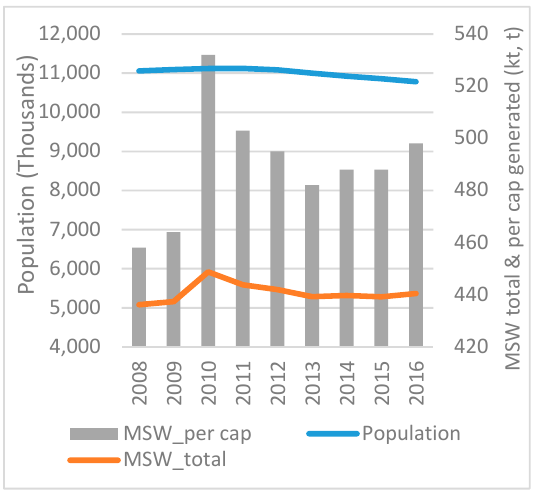
Figure 15. Population and MSW production in Greece 2008–2017 (EUROSTAT 2019a, 2019c). Soc. Sci. 2019 , 8 , x FOR PEER REVIEW